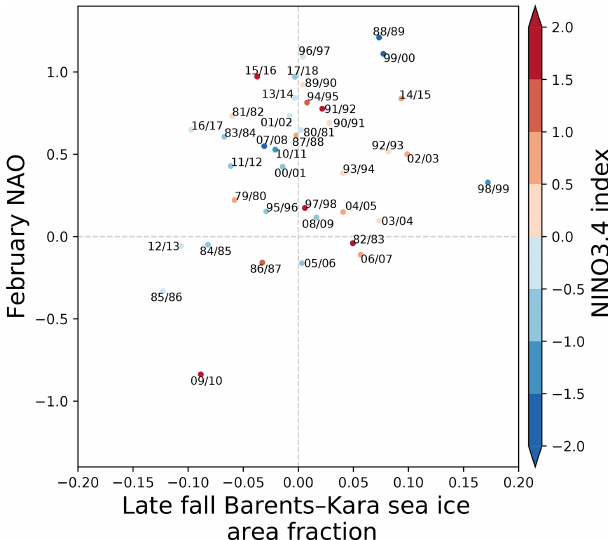
Figure 8. Scatter plots between February NAO and the late fall (mean of October and November) Barents–Kara sea ice index for the reanalysis period. Shading indicates the DJF NINO3.4 index. Red (blue) denotes El Niño (La Niña)